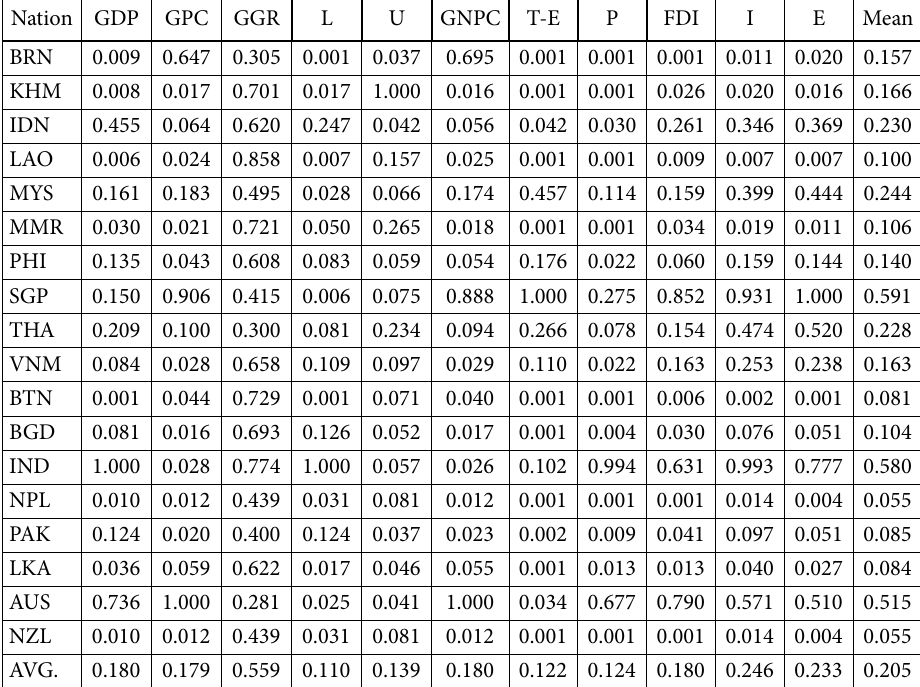
Table 4. Comparison of weights of various sub-indicators for each nation Nation